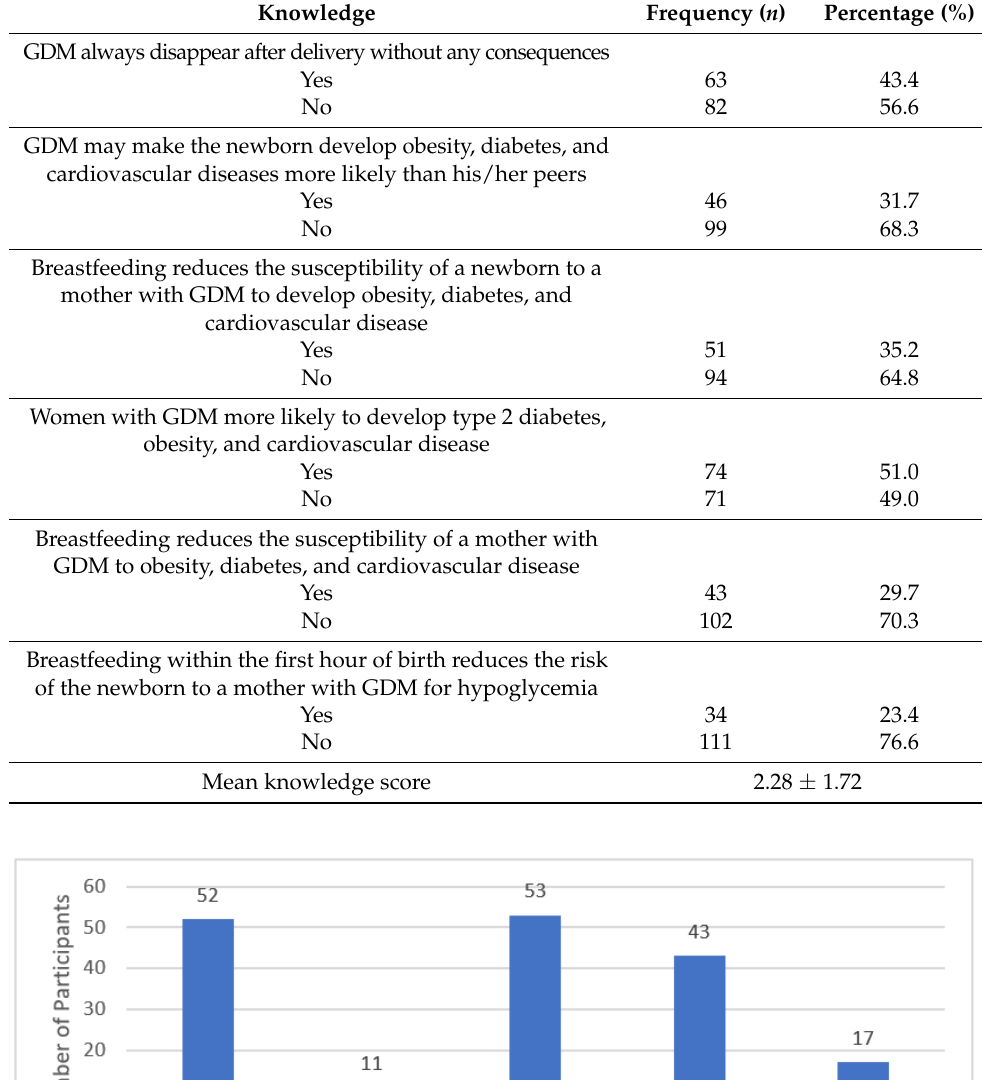
Table 3. Knowledge about gestational diabetes mellitus (GDM) of the participants and its correlation with the total prenatal breastfeeding self-efficacy Score ( n = 145).